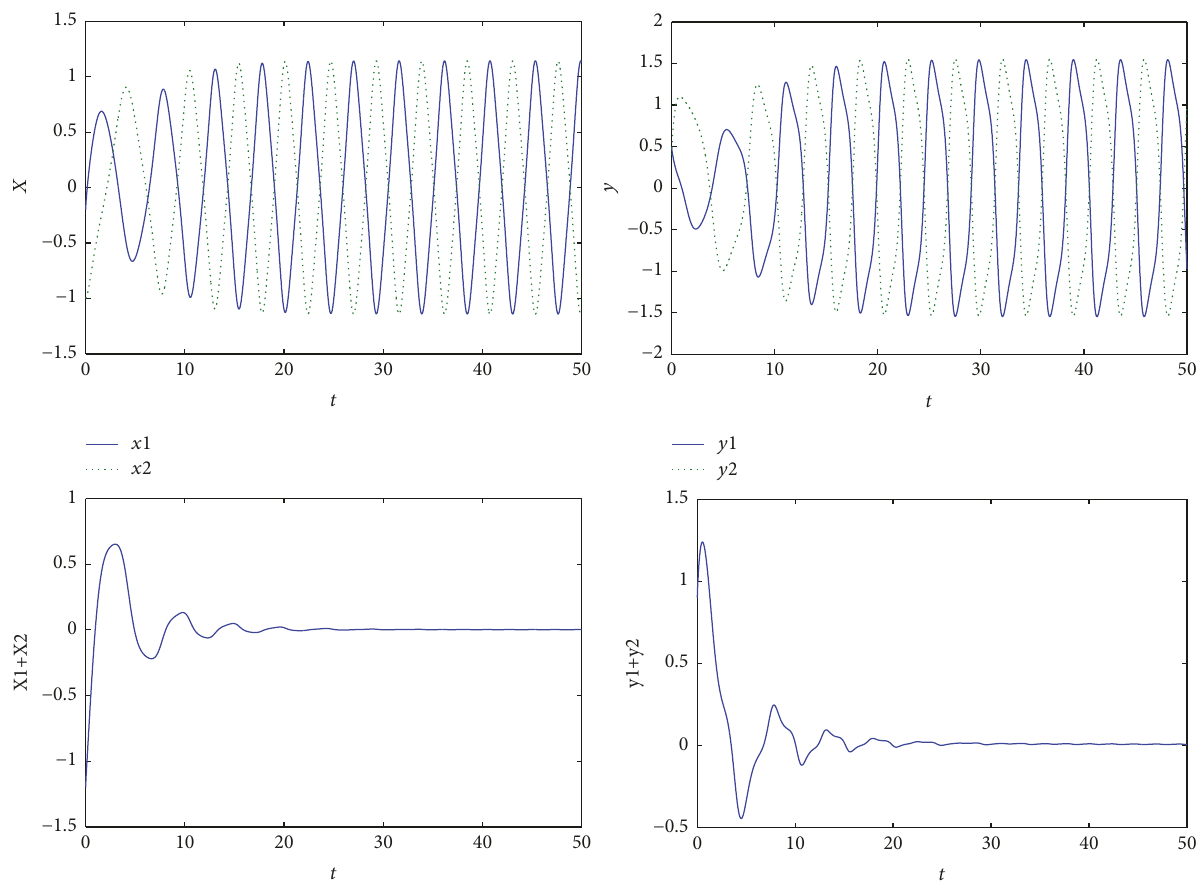
Figure 5: Antisynchronization of two unforced Duffing systems and the plot of errors 𝑥 1 + 𝑥 2 and 𝑦 1 + 𝑦 2 .